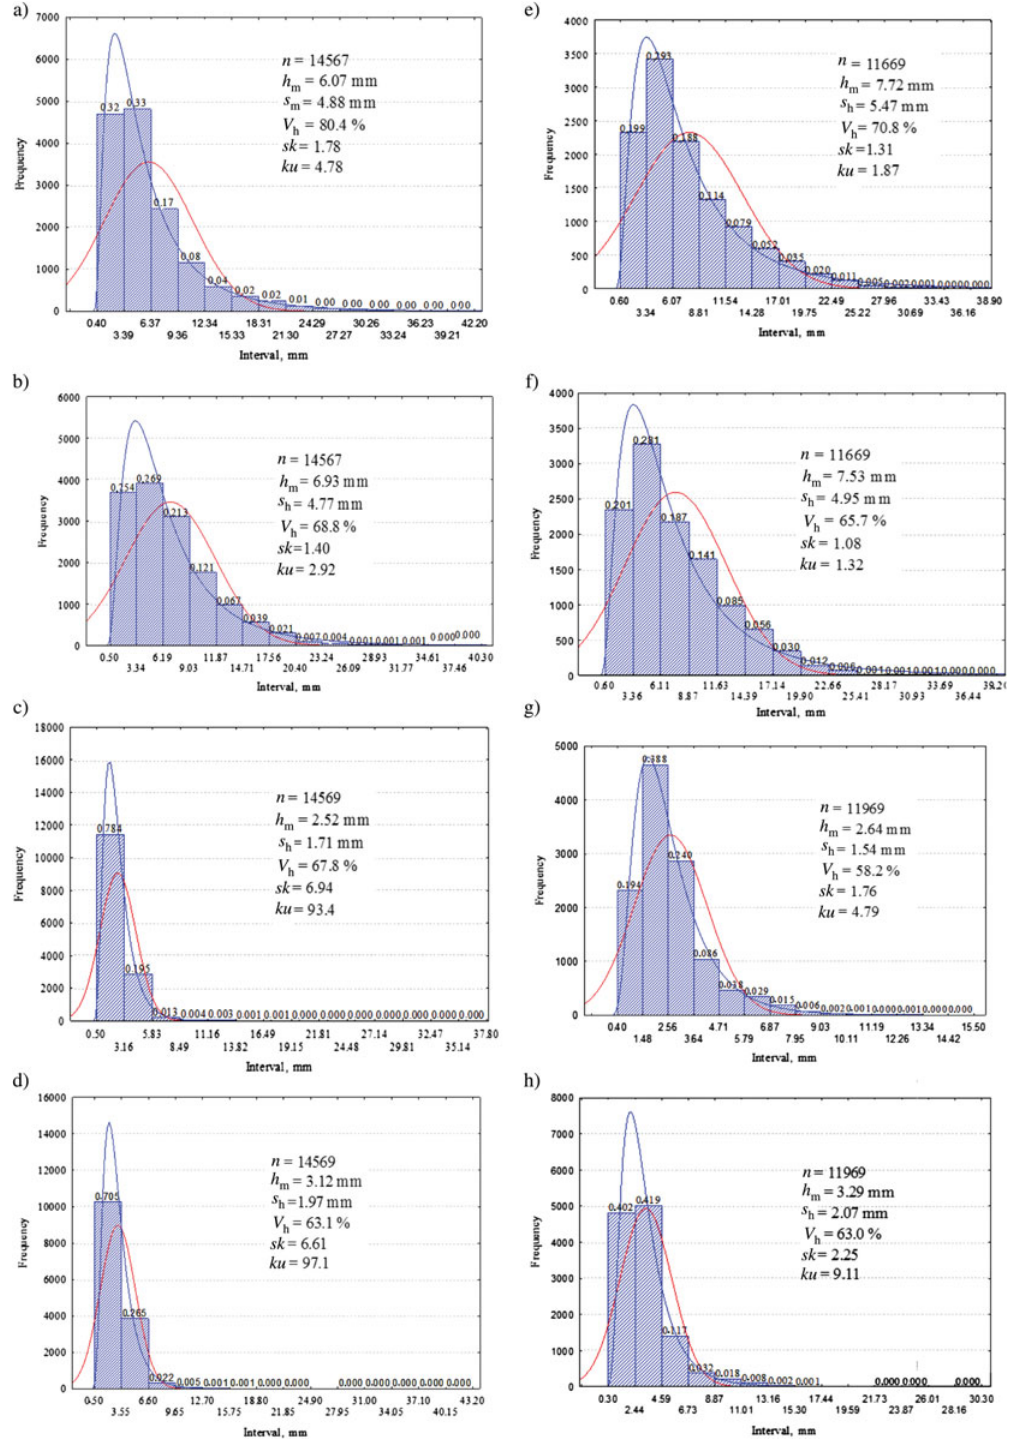
Fig. 2. The histograms of rut depth on the A1 highway, theoretical curves of normal and lognormal distribution and statistical indicators a (cid:3) d of Vilnius (cid:3) Kaunas (cid:3) Klaipe˙da rutting (1, 2, 3, 4) and e (cid:3) h of Klaipe˙da (cid:3) Kaunas (cid:3) Vilnius rutting (5, 6, 7,